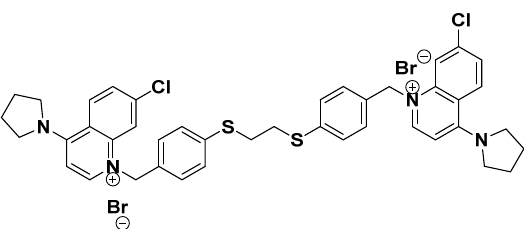
Figure 1. Chemical structure of synthetic ChoK α 1 inhibitor PL48. No PAINS (Pan Assay Interference Structures) were detected for the new inhibitor, ex-cluding the possibility of side effects due to unspecific activity of the chemical